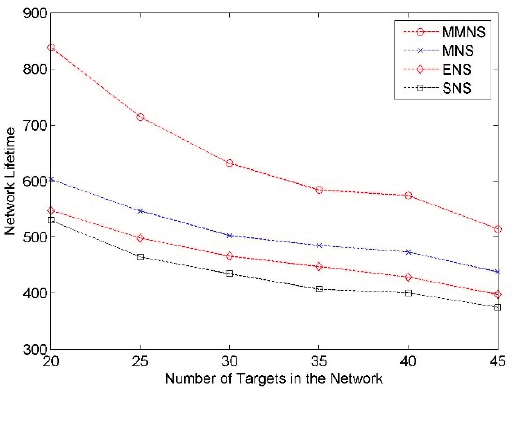
Figure 9. The impact of the number of targets on the network